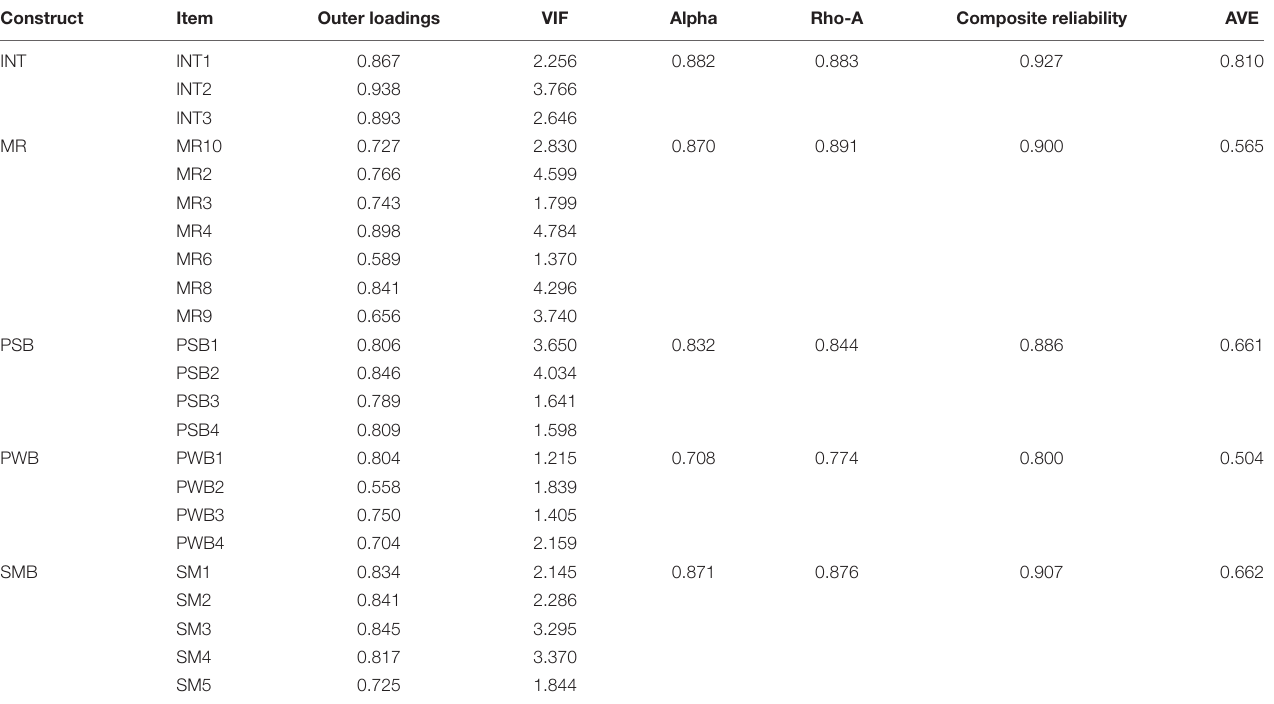
TABLE 1 | Reliability and validity of the study constructs.